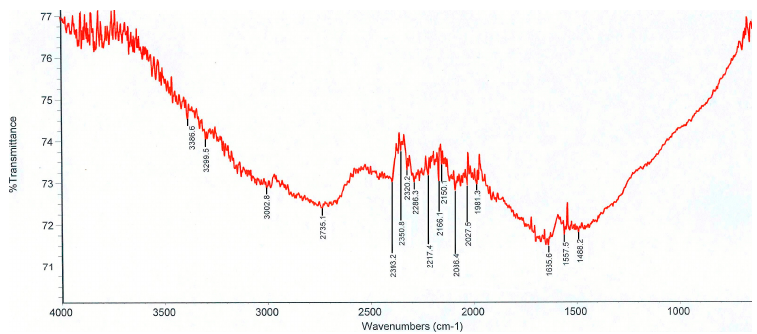
Figure 2. FTIR spectra of multi-walled carbon nanotube.